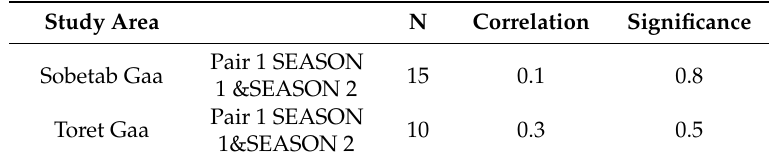
Table A14. Sample Correlations (Kipkaren